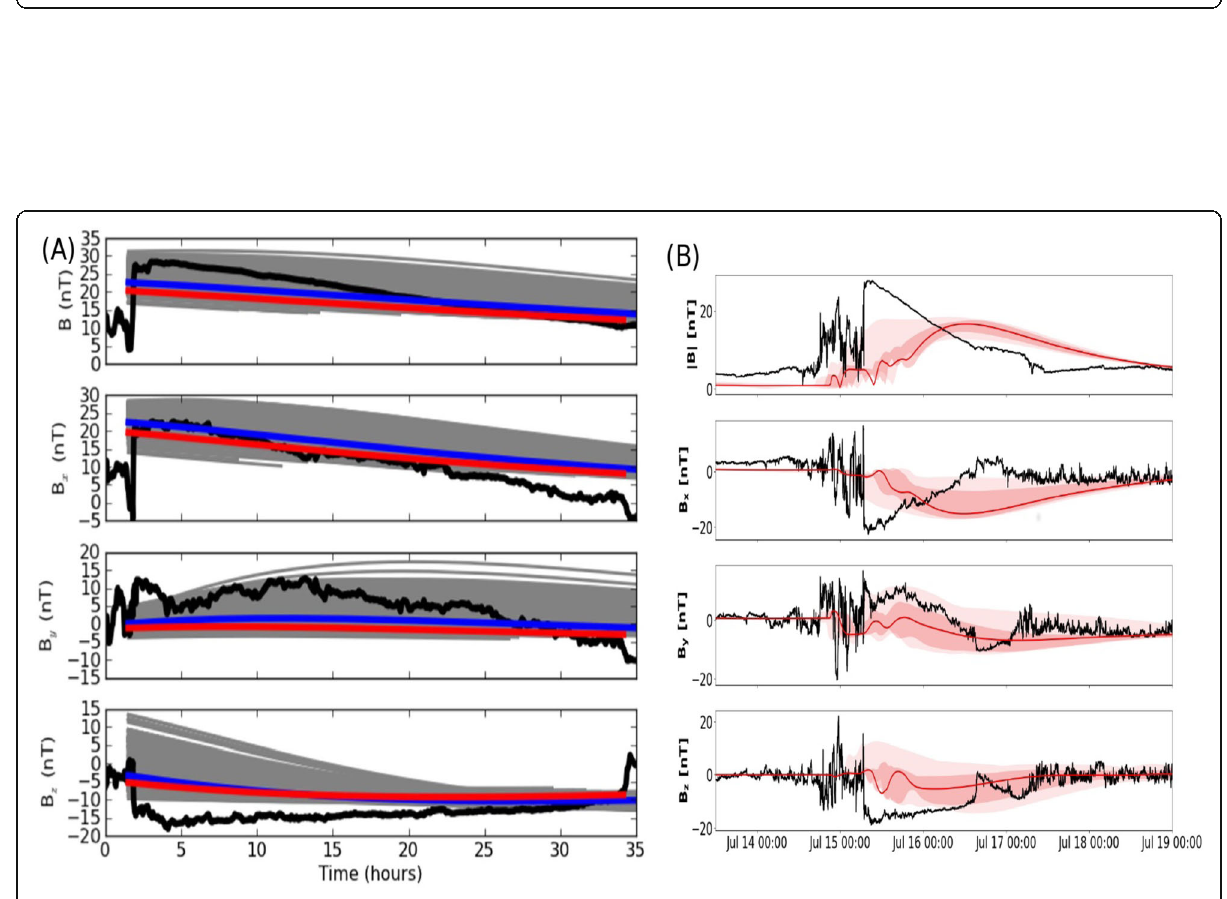
Fig. 38 Histograms of near-Sun CME axial magnetic fields at 10 Rs from two different methods. Panel A. From Patsourakos & Georgoulis (2017) (blue histogram corresponds to eruptive cases). Panel B. From Gopalswamy et al. (2018c) (results from CMEs corresponding to magnetic clouds upon impact at 1 AU)